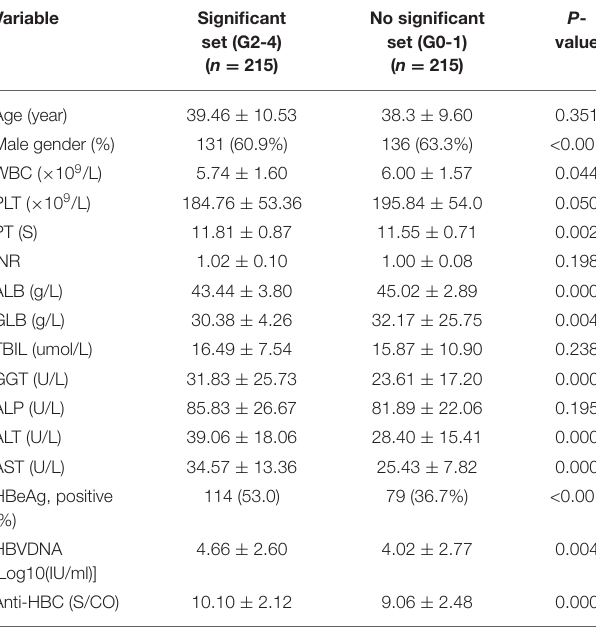
TABLE 1 | Baseline characteristics of patients in the training set and validation set. Variable